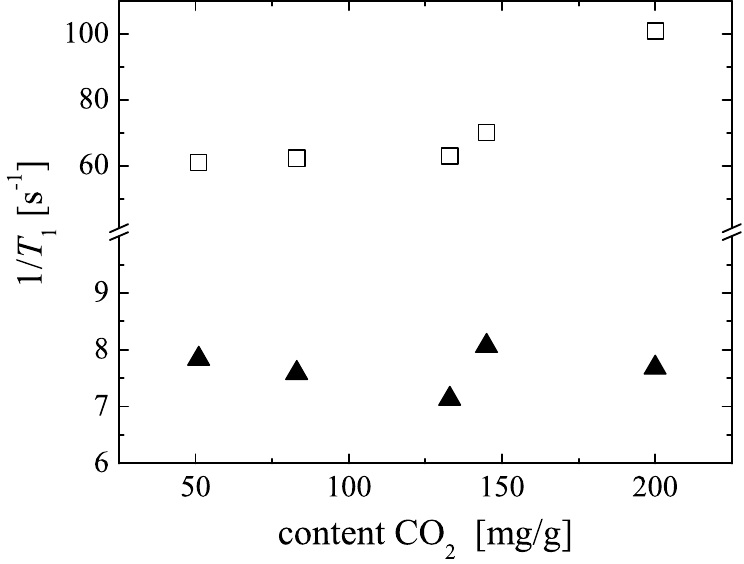
Figure 4. 13 C and 1 H longitudinal relaxation rates ( T − 1 ( N ) and CH ( (cid:3) ), respectively. The data are plotted for the mixture samples M1 to M5 in 4 dependence on the amount of adsorbed CO